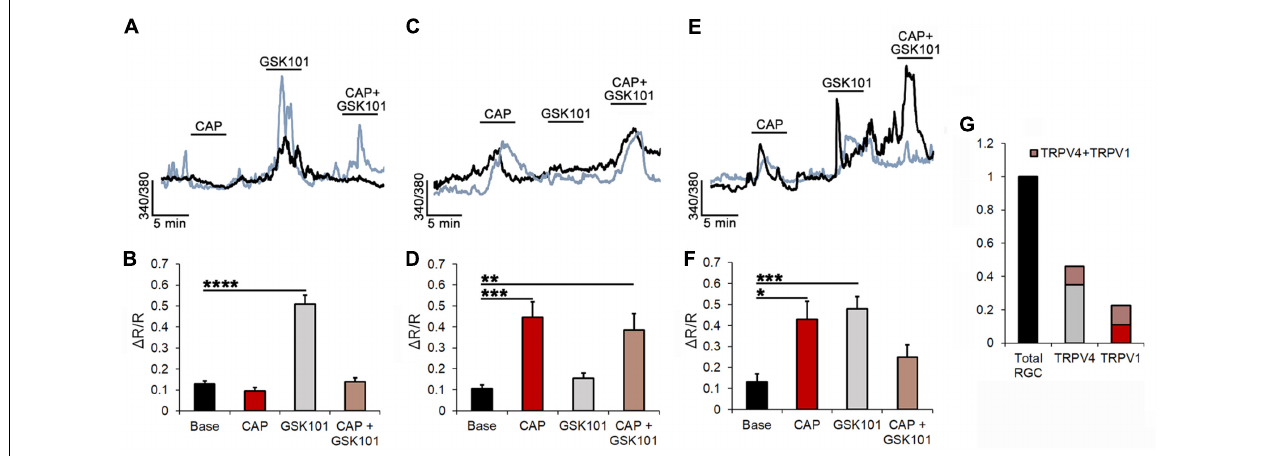
FIGURE 2 | TRPV1 and TRPV4 modulate Ca 2 + homeostasis in subsets of RGCs. (A) Two simultaneously recorded RGCs (denoted by black and blue traces) respond to GSK101 with [Ca 2 + ] i elevations but are insensitive to CAP. (B) Averaged data for the GSK101-responding CAP-insensitive pool of cells ( n = 87). (C) Representative traces of CAP responders that were insensitive to GSK101. (D) Averaged data for the CAP-responding GSK101-insensitive cohort ( n = 29). (E,F) Traces and averaged data from GSK101 + CAP responders ( n = 27). (G) Summary of averaged data. ∼ 24% of the TRPV4-expressing RGCs responded to CAP, whereas ∼ 48% of TRPV1-expressing RGCs responded to GSK101. ∗ P ≤ 0.05, ∗∗ P ≤ 0.01, ∗∗∗ P ≤ 0.001, ∗∗∗∗ P ≤ 0.0001.